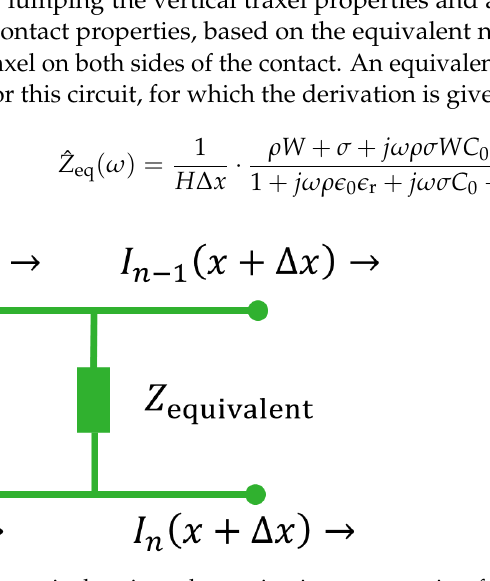
Figure 8. The equivalent impedance circuit representation for the electrical contact properties combined with the vertical bulk properties of a slice of ∆ x wide of two neighbouring